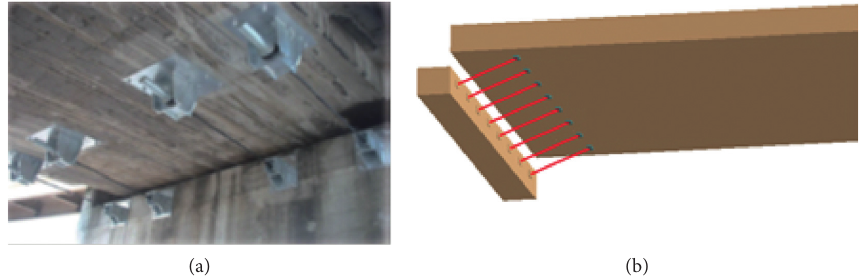
Figure 20: Using restrainer cables: (a) in practice and (b) in numerical modeling. Table 2: Impacting force on the first pier of the bridge in the case of using restrain cables in the connection of deck to abutment. Cable area (cm 2 )